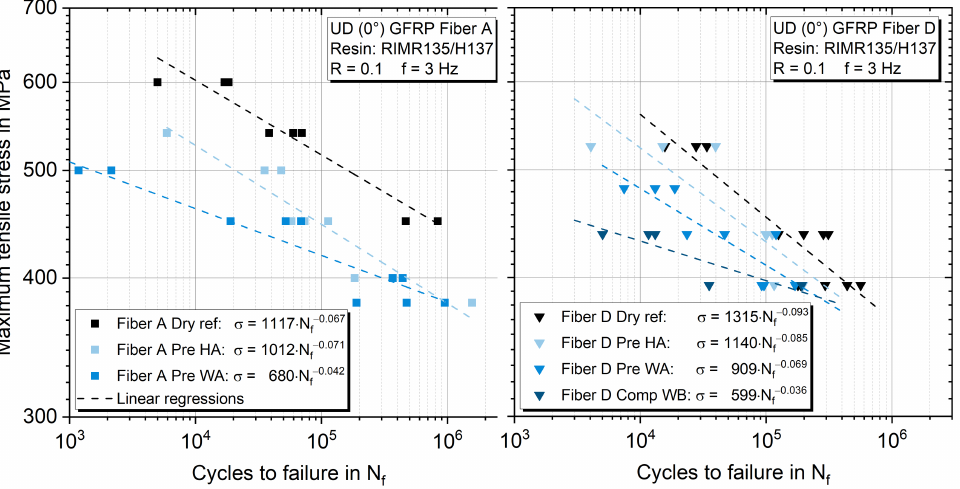
Figure 11. Fatigue life diagrams of fiber A ( left ) and D ( right ) UD GFRP composites (0 ◦ ) in dry, humid pre-aged, wet pre-aged, and composite wet aged